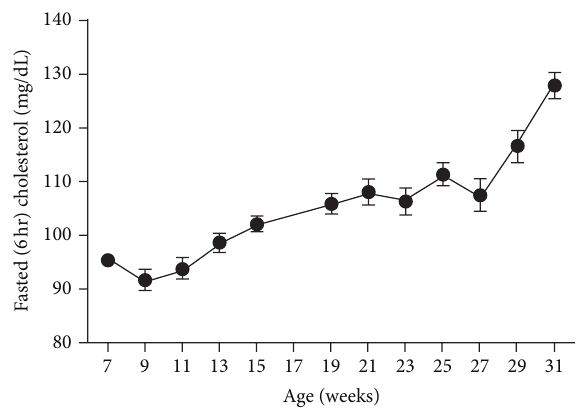
Figure 10: Fasted cholesterol in male ZDSD rats throughout the study duration of rats in ages from 7 to 31 weeks (mean ± SEM, 𝑛 = 23